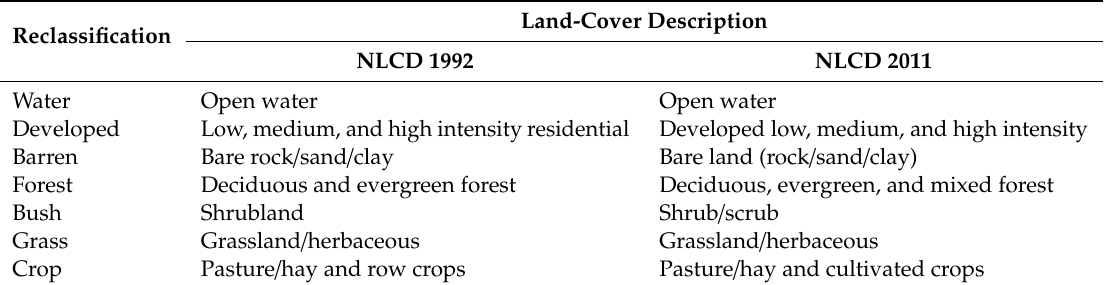
Table 3. Reclassification and land-cover description for the NLCD 1992 and